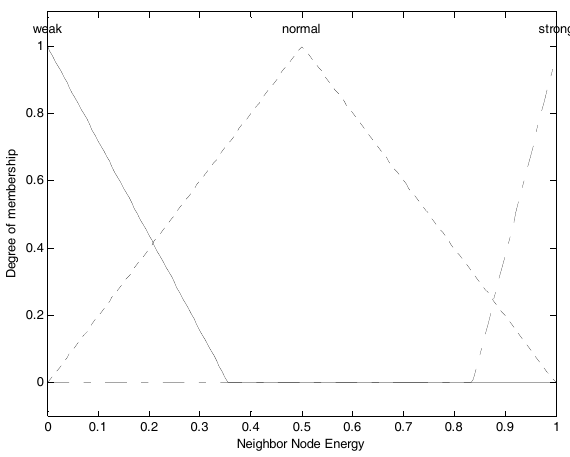
Figure 3. Nodes degree membership function.